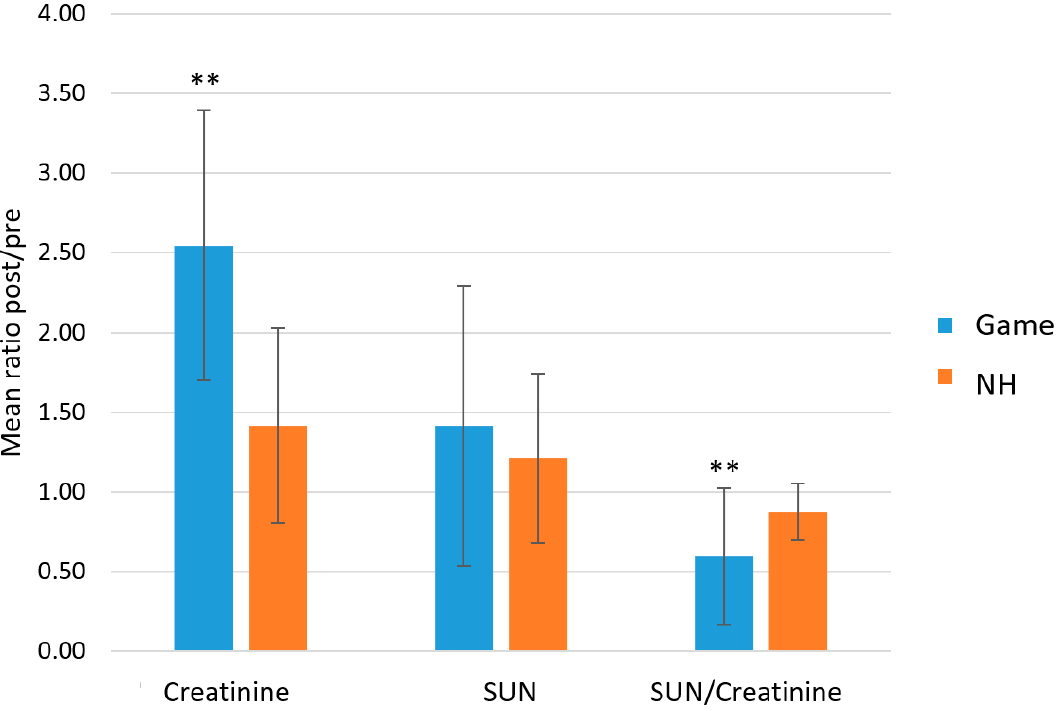
Figure 3. The ratio between post- and pre-game samples for creatinine, urea nitrogen (SUN), and the ratio SUN/creatinine for the game group and the normally hydrated (NH) group. The last includes both no-game and exit groups. ** p < 0.01. p values were obtained between pre- and post-samples of both game and NH groups. The last comprises both the exit and no-game groups (see text).